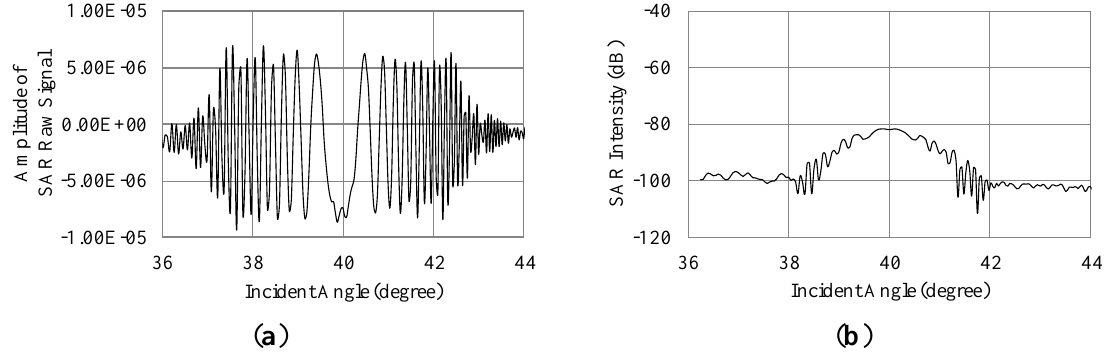
Figure 14. Influence Bragg resonant wave on microwave backscattering (Bragg resonant condition of 42 degrees). ( a ) Real part of SAR raw signal; ( b ) SAR